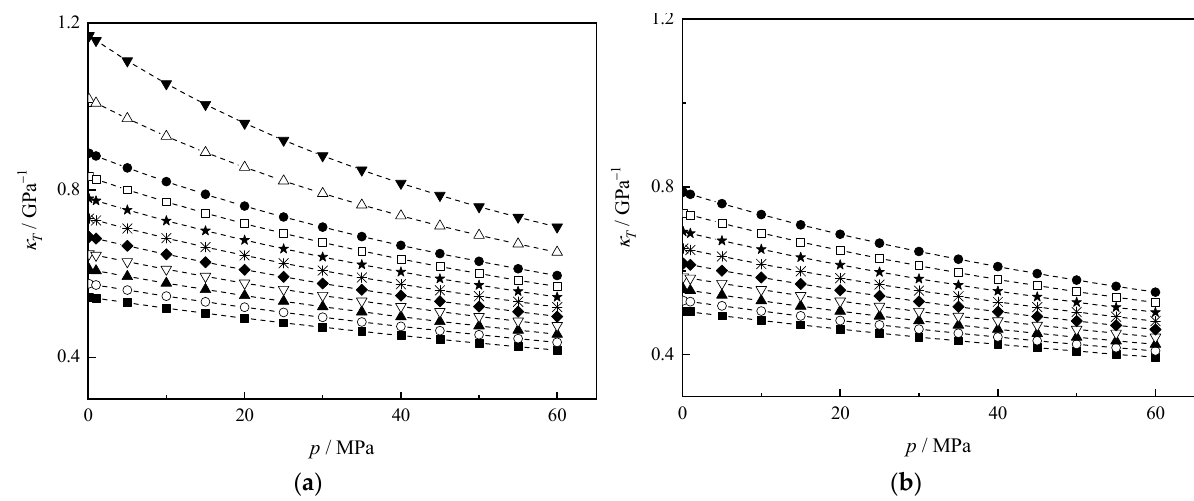
Figure 1. The percentage deviations of the measured ( a ) density, ρ , ( b ) dynamic viscosity, η , ( c ) speed of sound, u , and ( d ) refractive index, n D , from the literature data reported by: ( ) Almeida et al. [15], ( ) Bendiaf et al. [13], ( , ) Lomba et